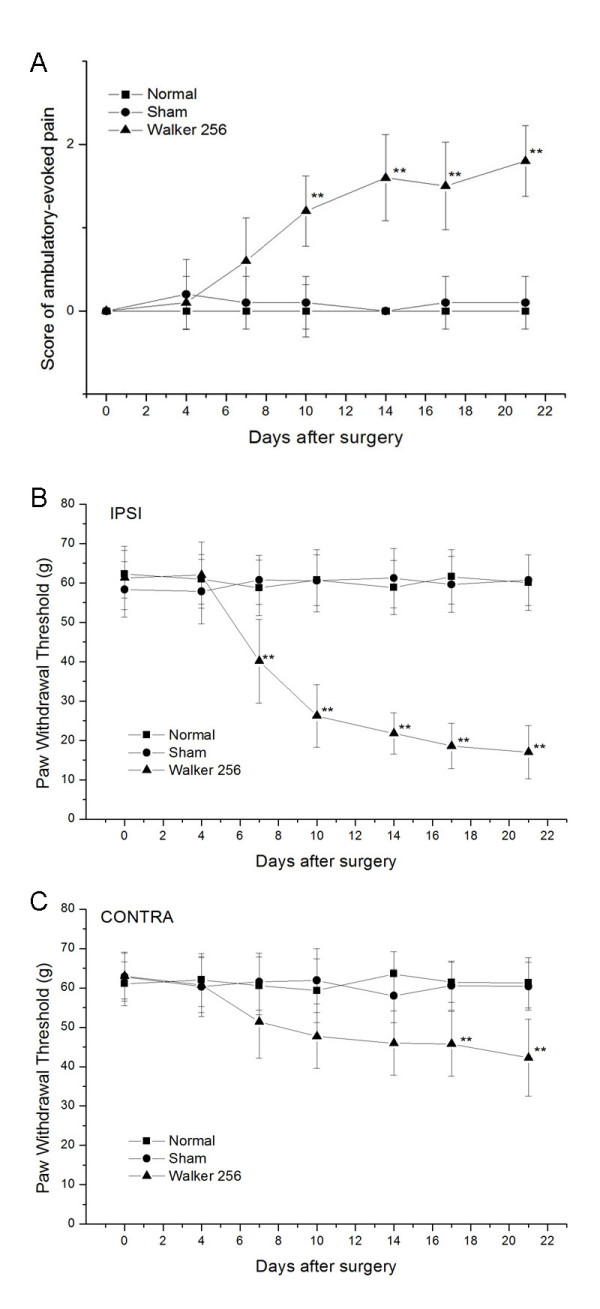
Time course of pain-related behavior in rats of the Walker 256 group (n = 10), the sham group (n = 10) and the normal group (n = 8). (A) The ambulatory score increased on days 10, 14, 17 and 21 after intra-tibial injection of Walker 256 carcinoma cells but not after injection of heat-killed cells. Data are expressed as mean ± SD. **P < 0.01 compared to normal rats. (B) After Walker 256 carcinoma cell inoculation, the PWT for the inoculated hind paw progressively decreased as revealed by electronic Von Frey filament stimulus. Data are mean ± SD. **P < 0.01 compared to normal rats. (C) The PWT for the contralateral hind paw of tumor-bearing rats changed slightly but significantly on days 17 and 21 Data are expressed as mean ± SD. **P < 0.01 (ANOVA) compared to normal rats.